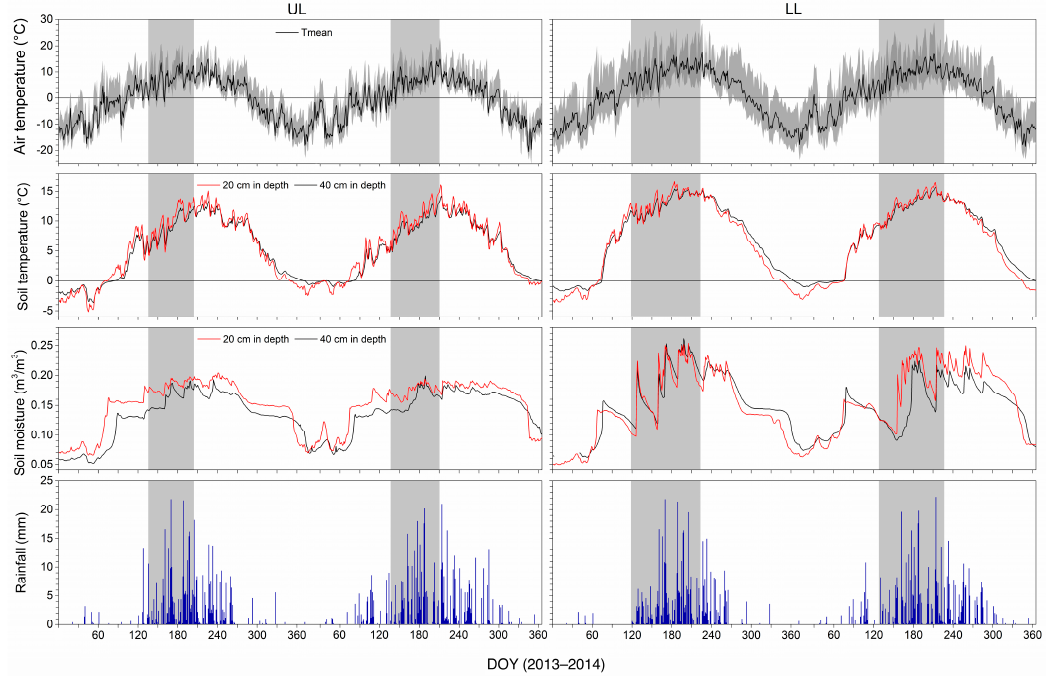
Figure 3. Daily time series of mean air temperature (minimum and maximum values are shown in dark gray), mean soil temperature and soil moisture of the upper (20 cm depth) and lower (40 cm depth) soil layers, and total rainfall at UL and LL during 2013 and 2014. Periods of cambial activity are shown by light gray